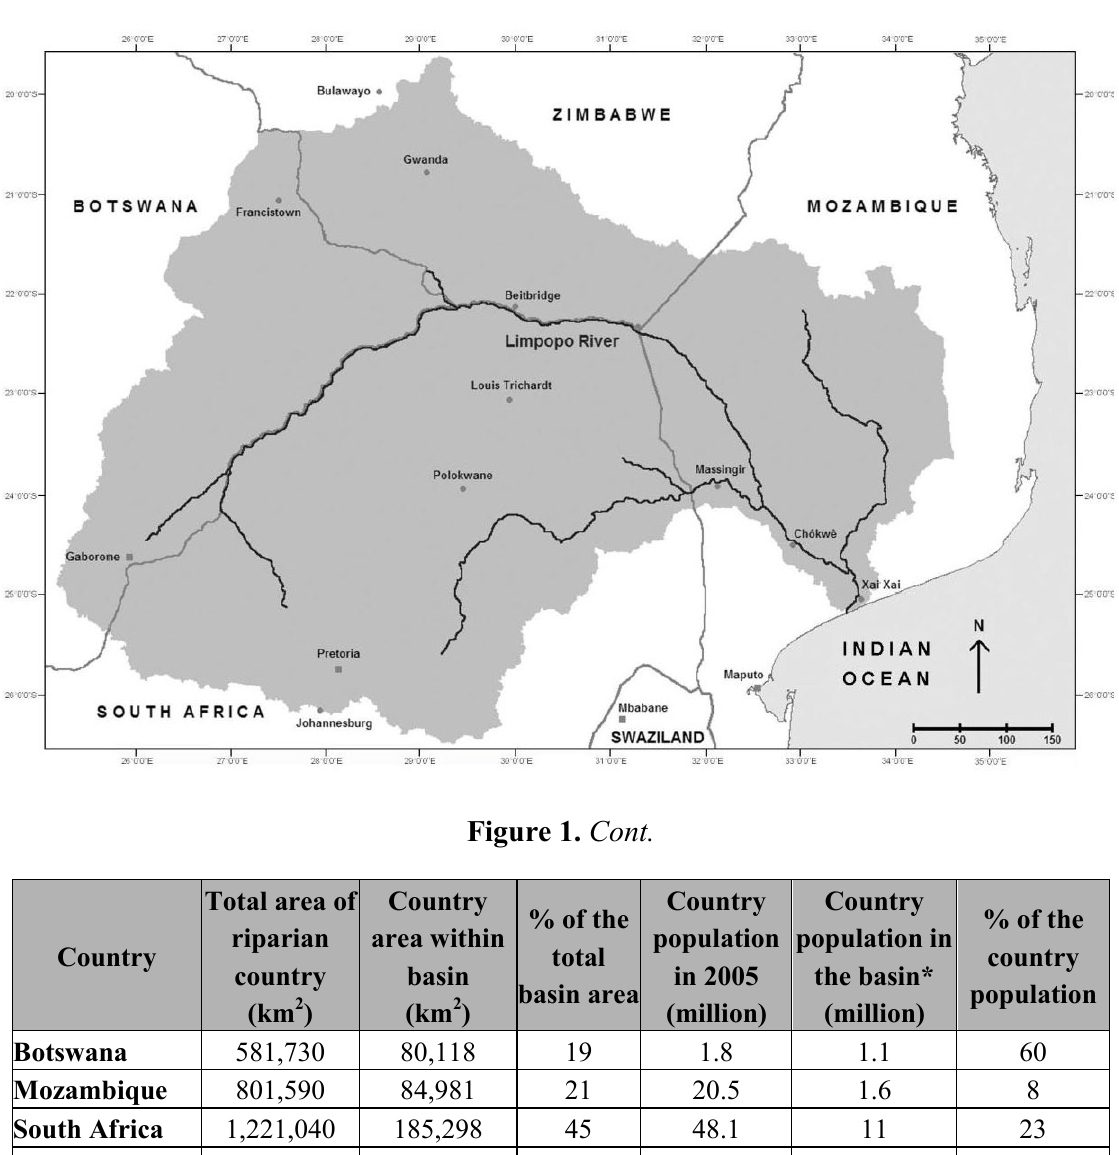
Figure 1. Geographical settings of the Limpopo River basin and population